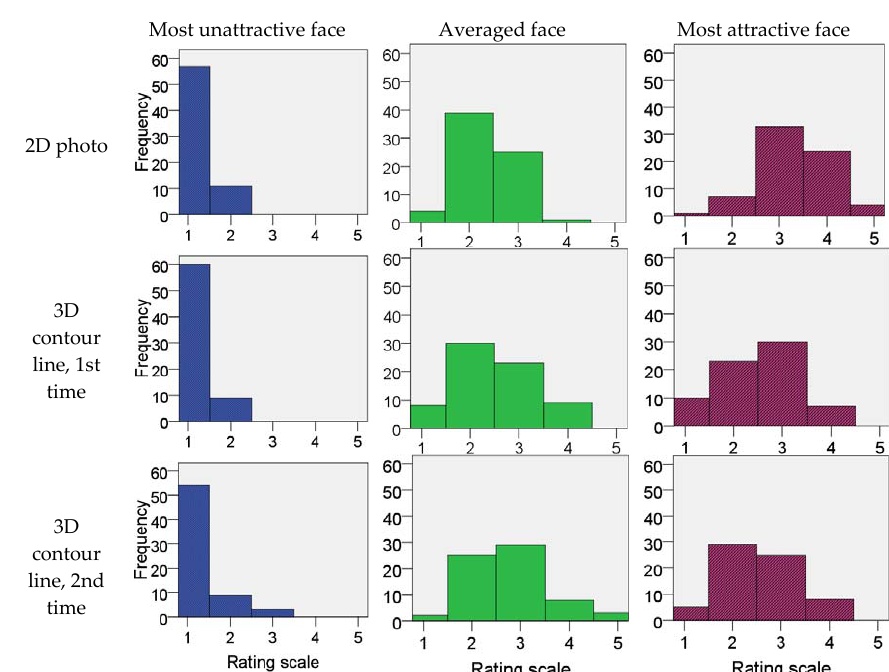
Figure 3. Frequency of rating scale for most unattractive ( left ), averaged ( middle ), most attractive ( right ) 2D photos ( upper row ), first evaluation of 3D contour lines ( middle row ) and second evaluation of 3D contour lines ( Lower row ). The unimodal distribution of the evaluating scores was shown in all evaluations.